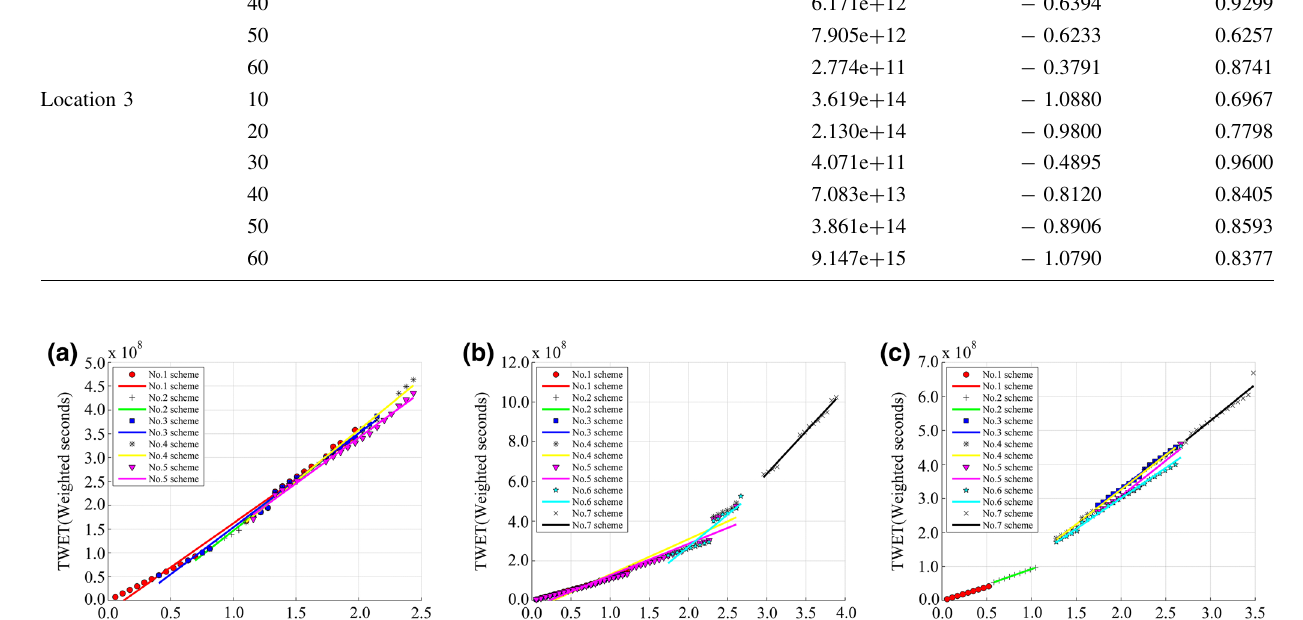
parameters for the fitting lines in Fig. 4 for different community location and population scenarios are shown in Table 2. High values of R 2 (measure of goodness-of-fit) indicate that the power function with the parameters pre- sented in Table 2 can show the relationship between TSA and TWET well, and these two variables are highly cor- related. The values of the parameter a are less than zero 1 for all scenarios, which indicates that TWET decreases as TSA increases. The values of R 2 are larger than 0.50 for most scenarios (more than 0.95 in some scenarios). That means the power function relationship is the best fit and robust for all scenarios.